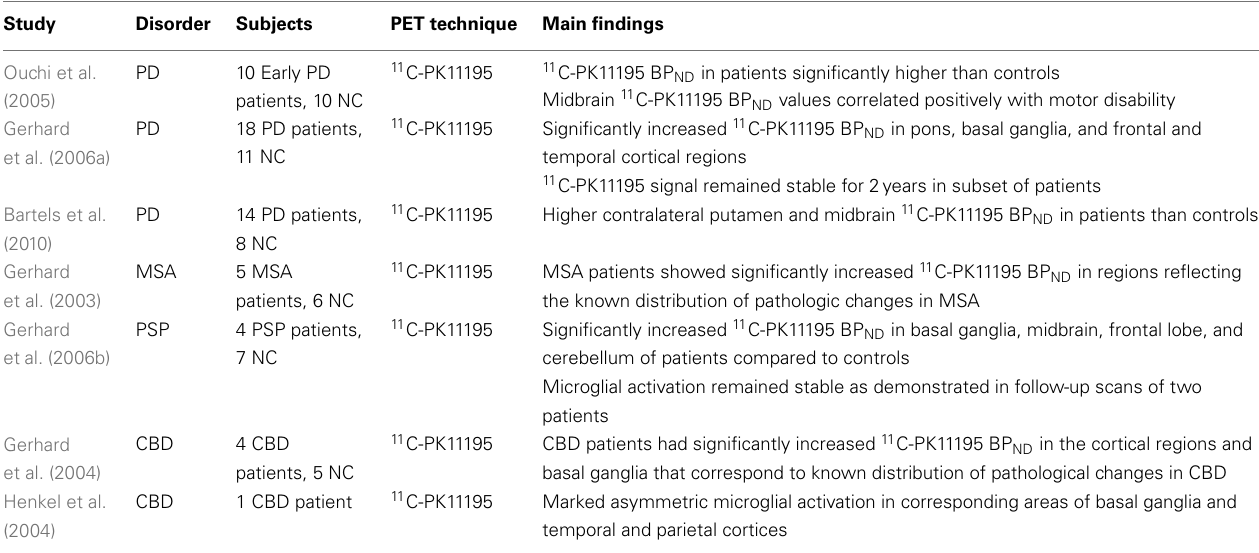
Table 1 | Positron emission tomography imaging studies assessing microglia in Parkinsonian